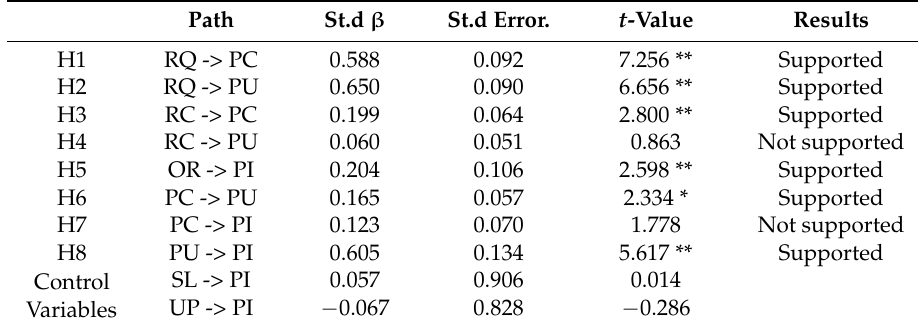
Table 5. Summary of hypothesis test.